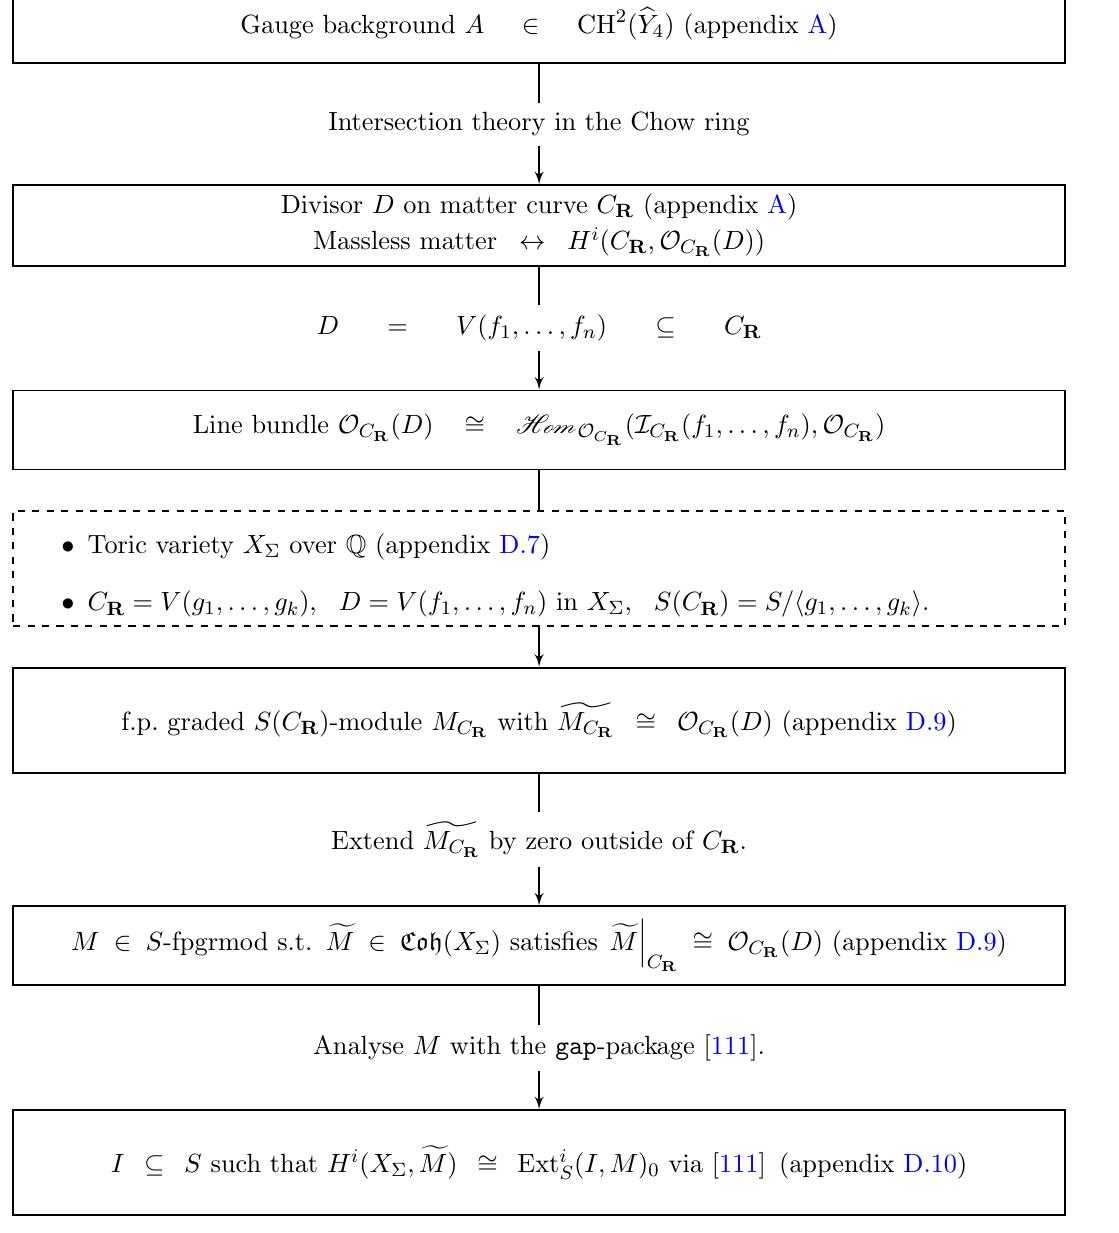
( D )) ’ H i ( X (cid:6) ; f M ) encode the massless R